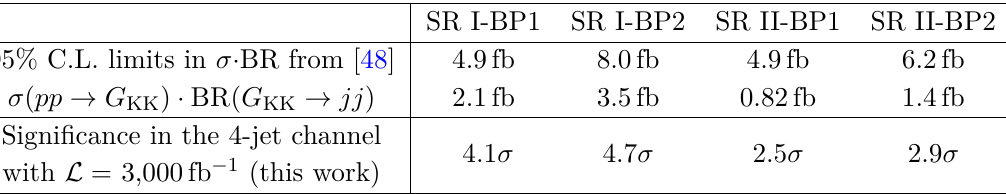
Table 8 . Comparisons between the 95% C.L. upper limits in resonance production cross-section multiplied by the BR to a jet pair at the HL-LHC ( L = 3,000 fb − 1 ) [48] (second row) and the KK graviton production cross-section multiplied by its BR to two jets under our model setup (third row). For ease of reference we import the expected experimental sensitivities to the KK graviton in the 4-jet channel from tables 2 through 5 (last